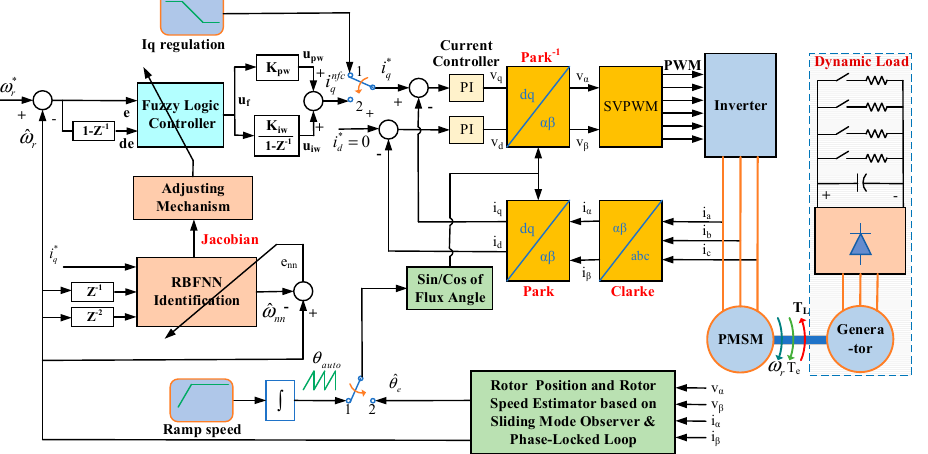
Figure 1. The overall architecture of the neural fuzzy controller (NFC)-based speed controller for the sensorless permanent magnet synchronous motor (PMSM) drive control system.